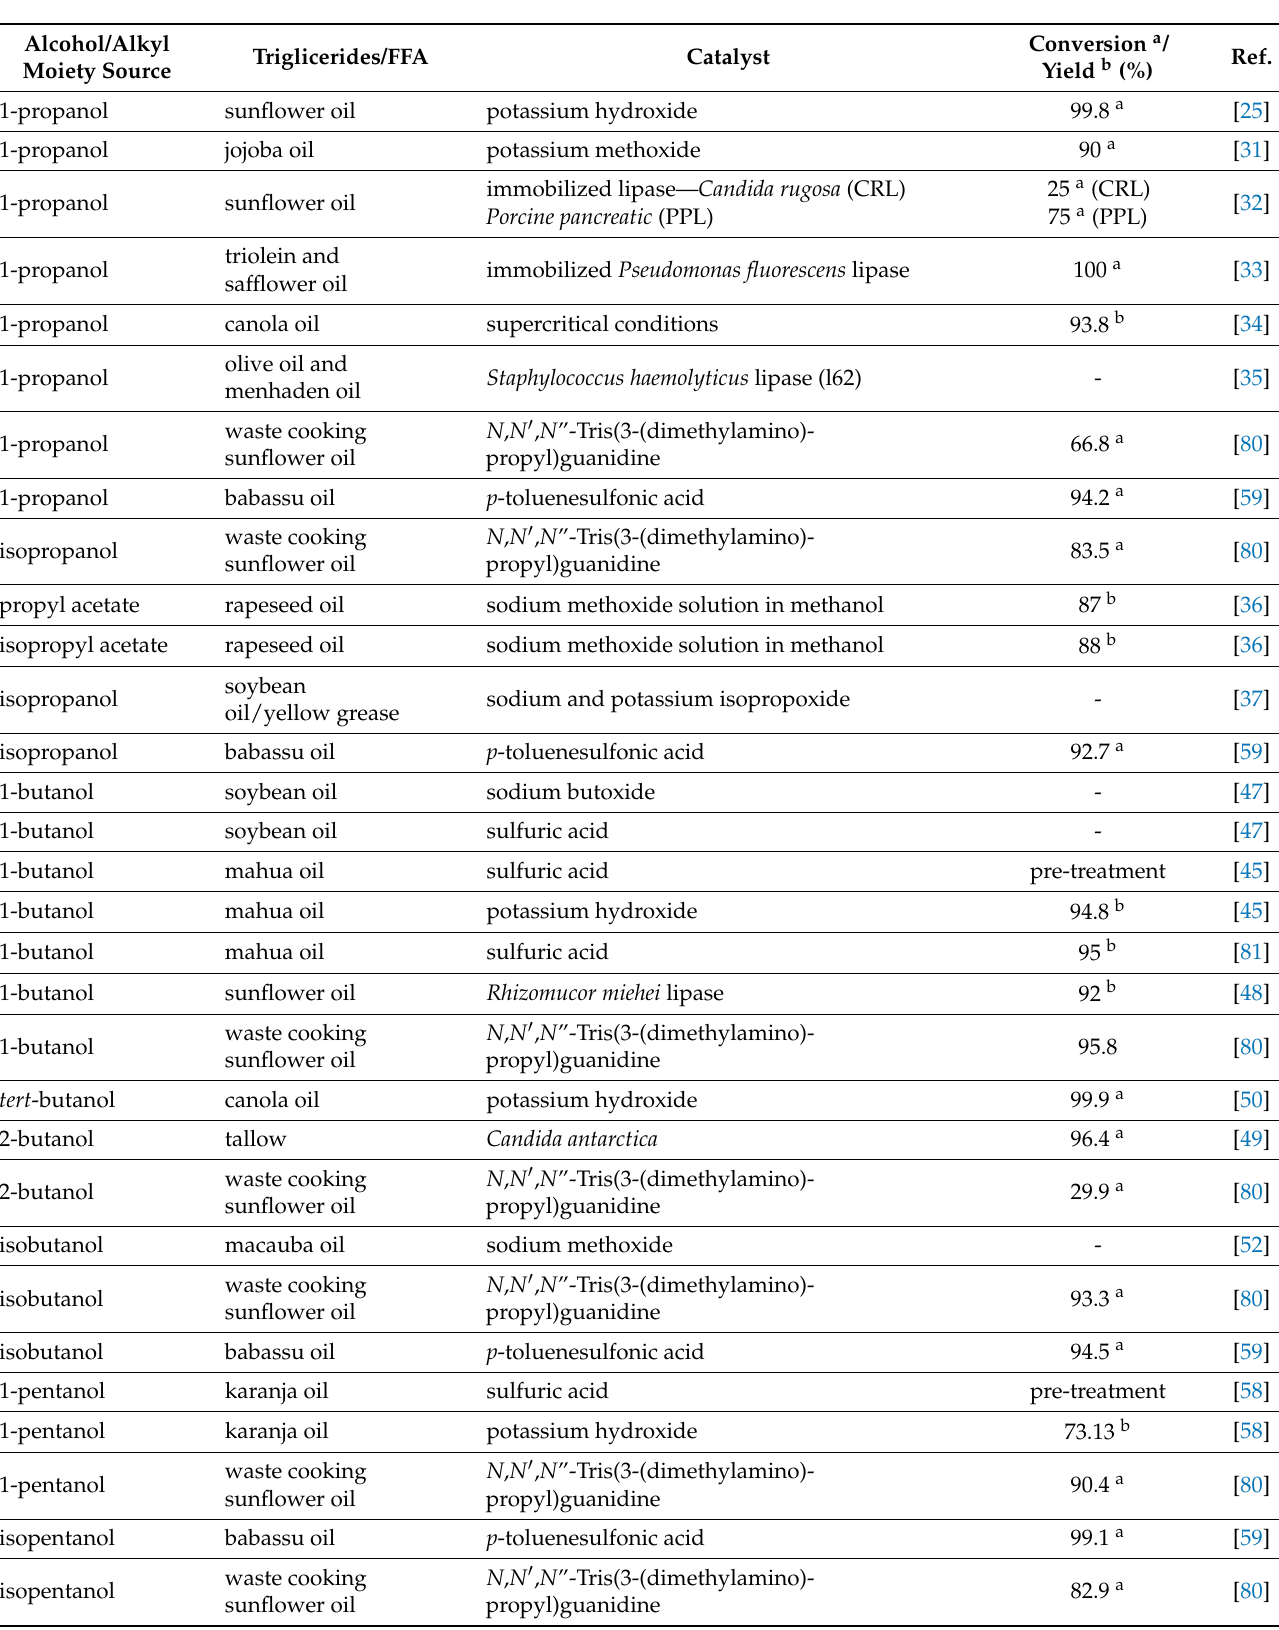
Table 1. Production of